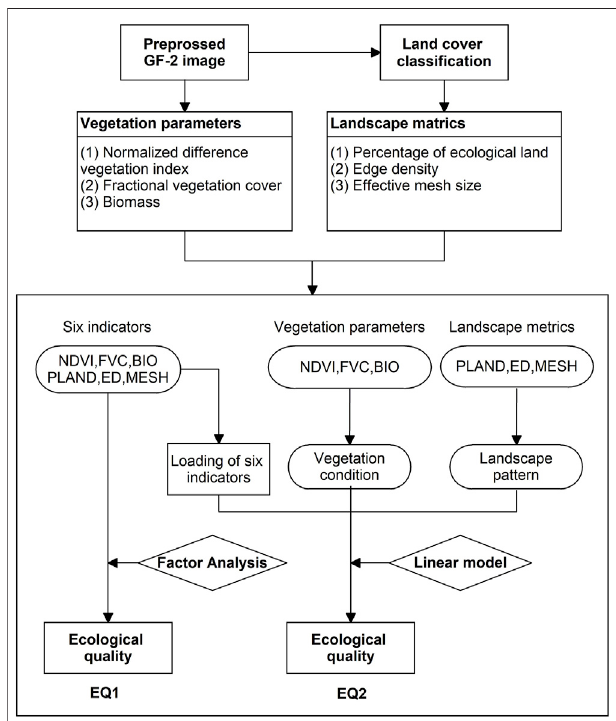
FIGURE 2 | The framework of ecological quality evaluation using GF-2 remote sensing